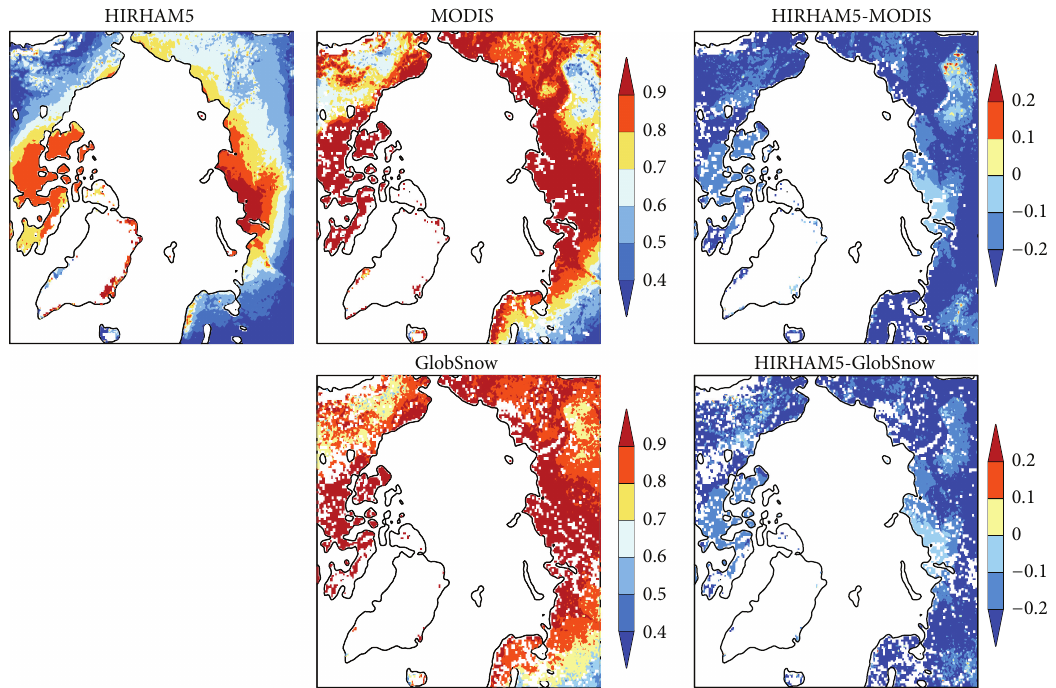
Figure 5: Snow cover fraction averaged over 2008–2010 for spring derived from HIRHAM5, MODIS, GlobSnow and their corresponding differences “HIRHAM5 minus MODIS” and “HIRHAM5 minus GlobSnow”.